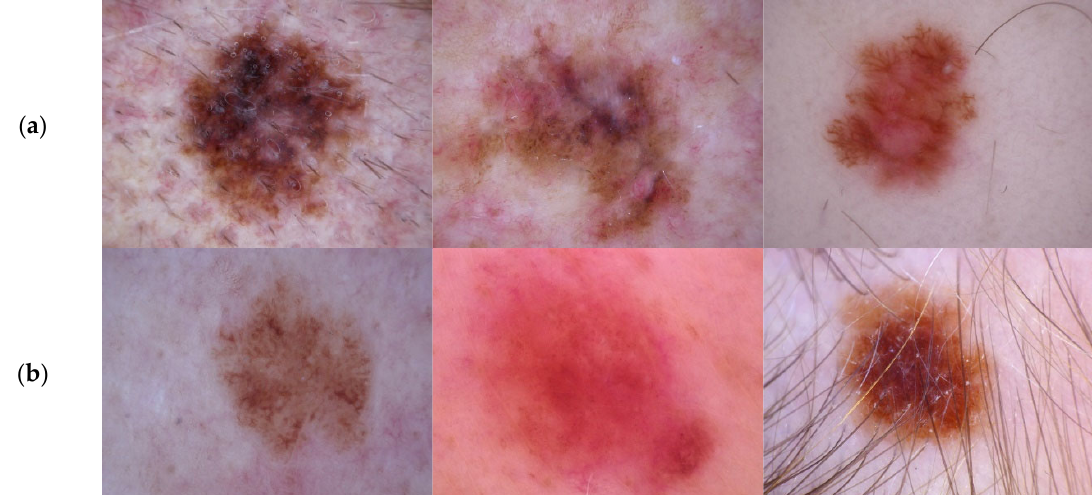
Figure 6. Sample dermoscopy images, ( a ) Melanoma, ( b ) Non ‐ melanoma.